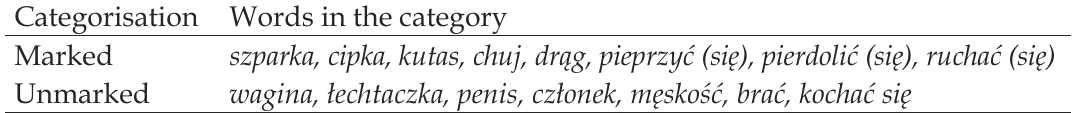
Categorisation of taboo vocabulary from the Polish corpus Categorisation Words in the category Marked Unmarked